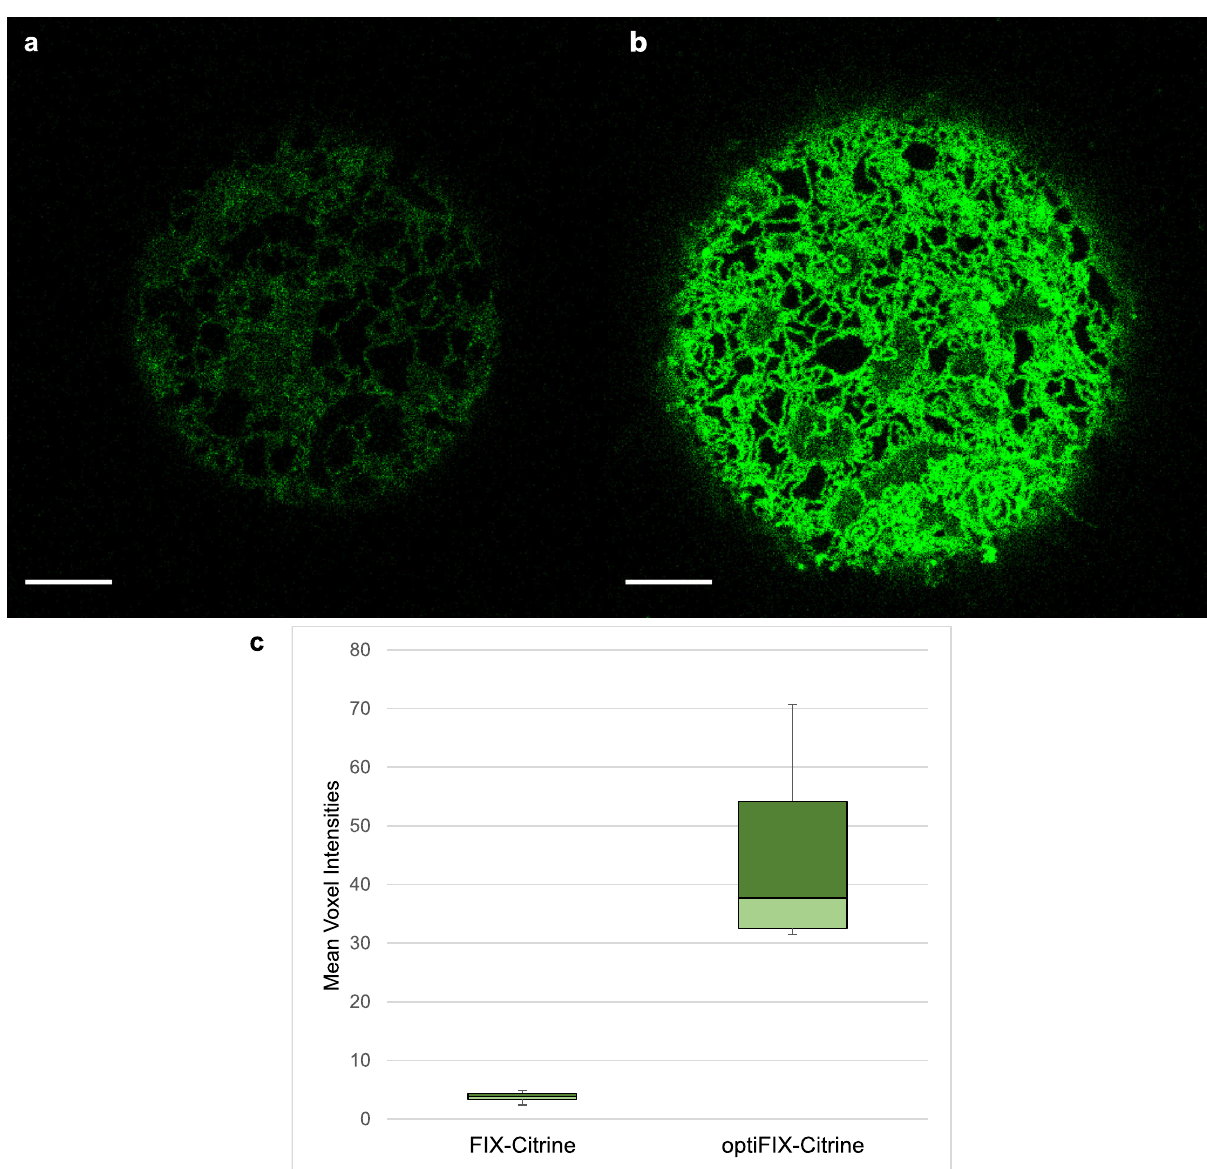
Fig. 6 Comparison of FIX and optiFIX protein levels in Physcomitrella protoplasts using confocal microscopy and quantitative image analysis. a Transient overexpression of FIX-Citrine. The slice with the brightest mean intensity was extracted from a Z-stack and its voxel intensity range was adjusted to (0 – 36) for illustration. The scale bar is 5 µ m. b Transient overexpression of optiFIX-Citrine. The slice with the brightest mean intensity was extracted from a Z-stack and its voxel intensity range was adjusted to (0 – 36) for illustration. The scale bar is 5 µ m. c Comparison of the mean signal intensities of the Z-stacks for FIX-Citrine and optiFIX-Citrine ( n = 3). Statistical signi fi cance was tested by one-way ANOVA ( p = 0.03413). Table 2 Underrepresented codons were changed into the overrepresented ones based on the codon usage tables 49,50 to optimize FIX sequence using aspFIX as a